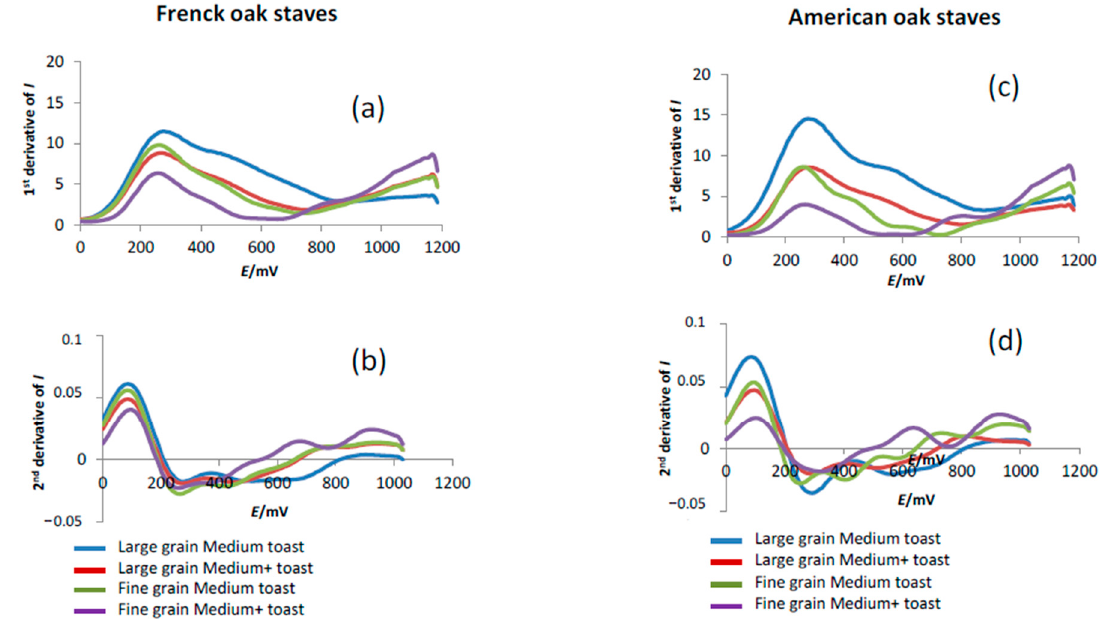
Figure 4. First ( a , c ) and 2nd ( b , d ) derivative voltammograms of French ( a , b ) and American ( c , d ) oak staves.